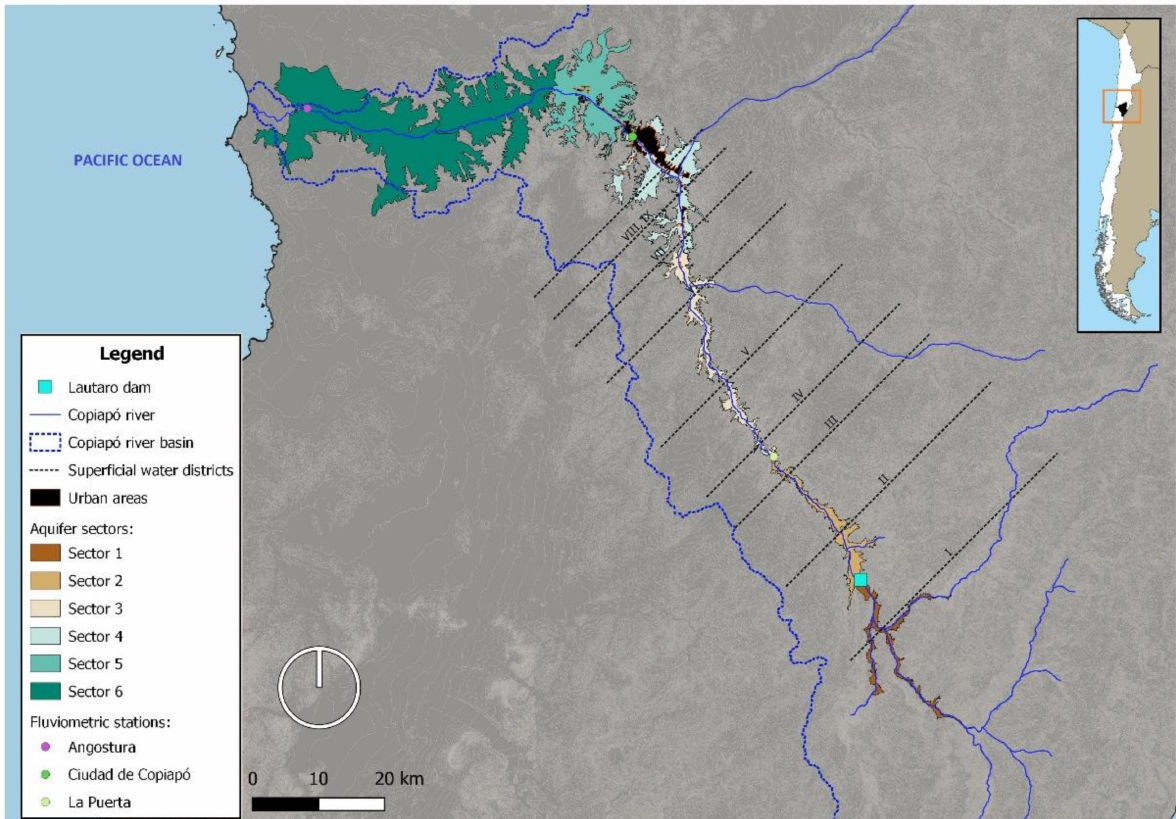
Figure 1. Location of the Copiap ó River basin, main groundwater (aquifer) sectors, surface